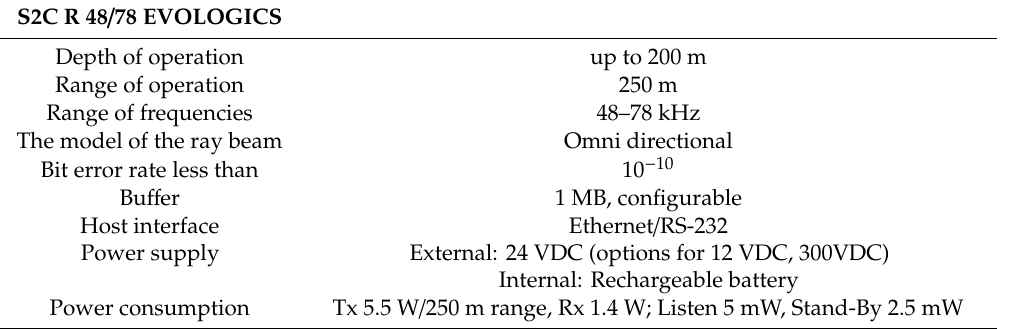
Table 3. Technical specification of S2C R 48 / 78 EVOLOGICS